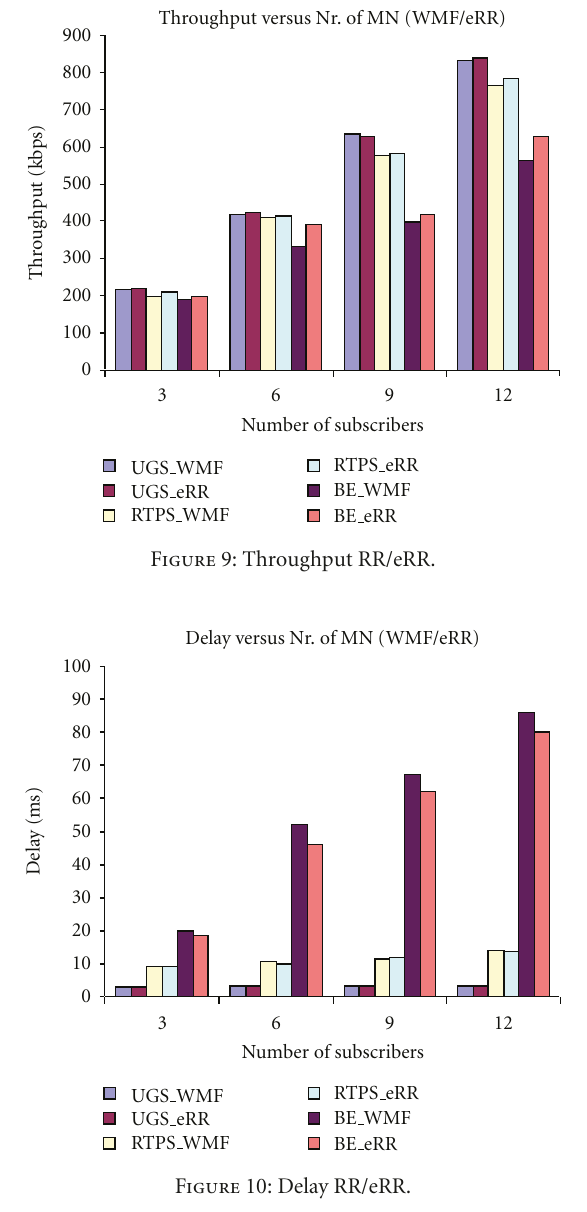
Figure 10: Delay RR/eRR.